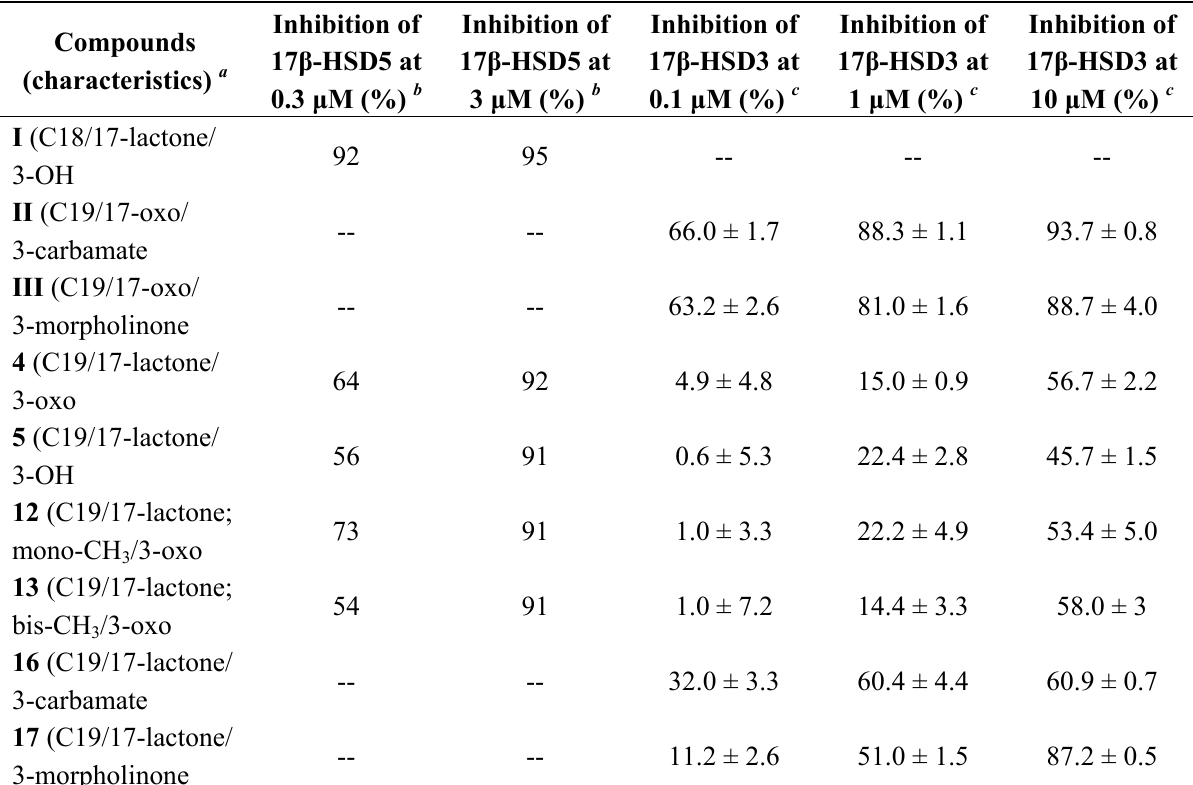
Table 1. Inhibition of 17 β -HSD5 and 17 β -HSD3 by compounds 4 , 5 , 12 , 13 , 16 and 17 .